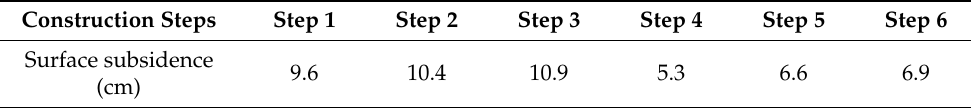
Table 5. Surface subsidence of each construction